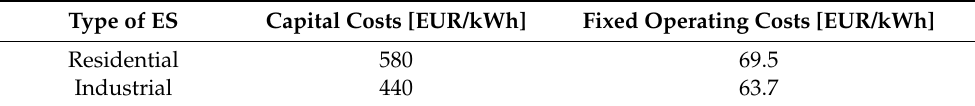
Table 3. Costs of ES